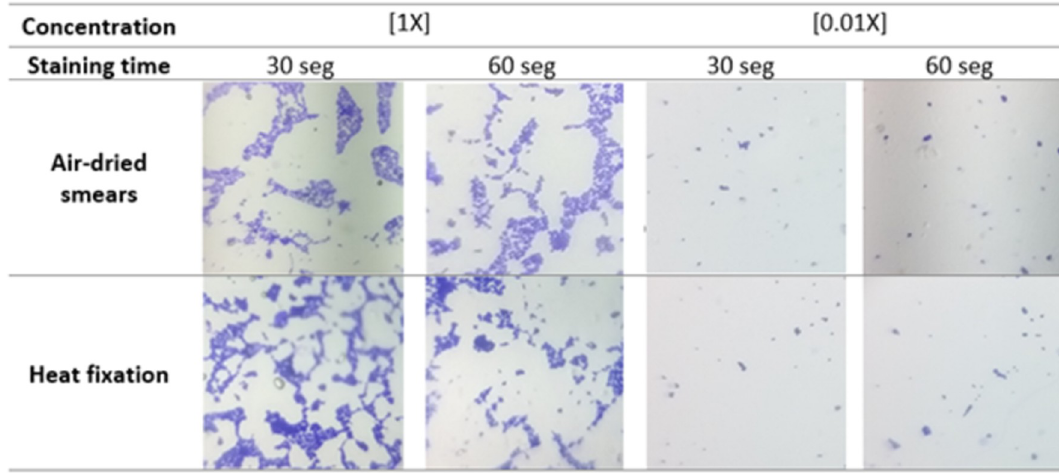
Fig 3. Selection of slide preparation